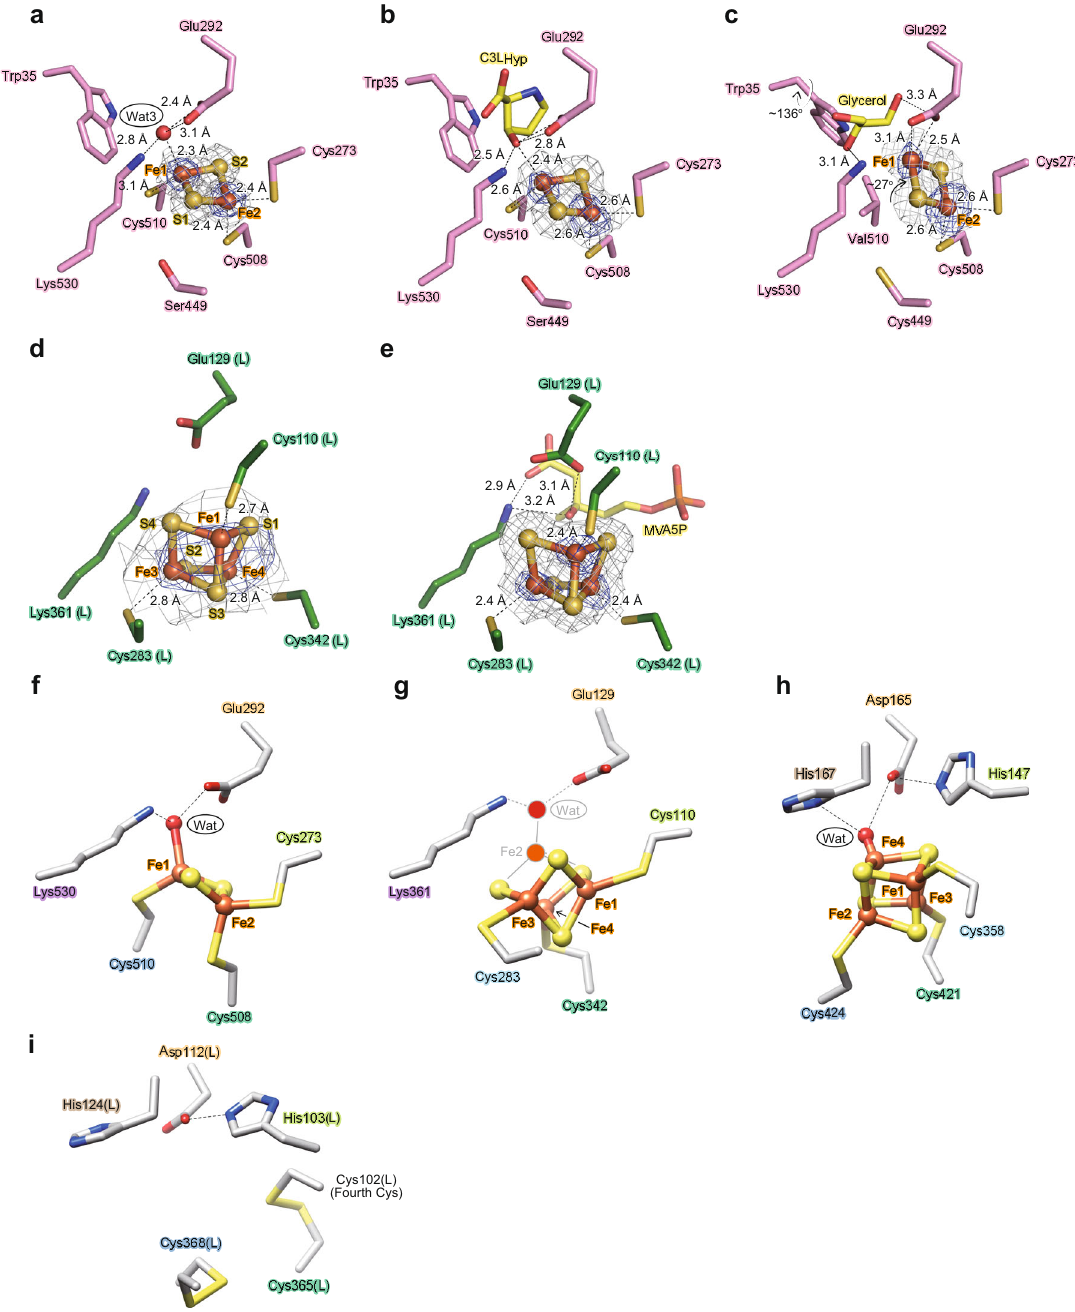
Fig. 4 Analysis of the [Fe-S] cluster in AcnX. The observed [2Fe-2S] cluster of AtAcnX in the apo-form ( a ) and in complex with C3LHyp ( b ) of the wild- type enzyme, and in the apo-form of the S449C/C510V mutant ( c ). The observed [3Fe-4S] cluster of TkAcnX in the apo-form ( d ) and in complex with MVA5P ( e ). 2 mF o – DF c electron density maps for the [Fe-S] cluster, contoured at 1.5 σ , are shown as a gray mesh. Anomalous difference Fourier maps, contoured at the 5.0 σ ( a ), 3.0 σ ( b ), 4.0 σ ( c ), 3.0 σ ( d ), and 9.0 σ levels ( e ), indicate peaks for Fe atoms, and are shown as a blue mesh. Superposition of [Fe-S] clusters of AtAcnX ( f ), TkAcnX ( g ), mAcn ( h ; 6ACN), and IPMI ( i ; 4KP2) within its active sites, ligated to protein cysteines by Fe-S bonds. Amino- acid residues located at equivalent (or close) positions are indicated in the same color and correspond to Fig. 2. The hypothetically activated [4Fe-4S] cluster of TkAcnX, the Fe2 atom, and a water molecule (gray) appeared to be coordinated to the [3Fe-4S] four chains of TkAcnX L (chains A, C, E, and G), the 1 – 386) superimposed well on residues 1 – 144 and 157 – 558 of conformations of which (except for the chain B) were very AtAcnX, with r.m.s.d. values of 1.3 Å over 122 C α atoms and 1.6 similar; r.m.s.d. values on the C α atoms were 0.36 – 0.42 and Å over 372 C α atoms, respectively (Supplementary Fig. 2). Small 0.29 – 0.37 Å, respectively. As expected from the primary structure, differences in folding were only observed in TkAcnX S ; the N-terminal region formed an additional β -strand ( β 1), by which each TkAcnX S (residues 1 – 130) and TkAcnX L subunit (residues